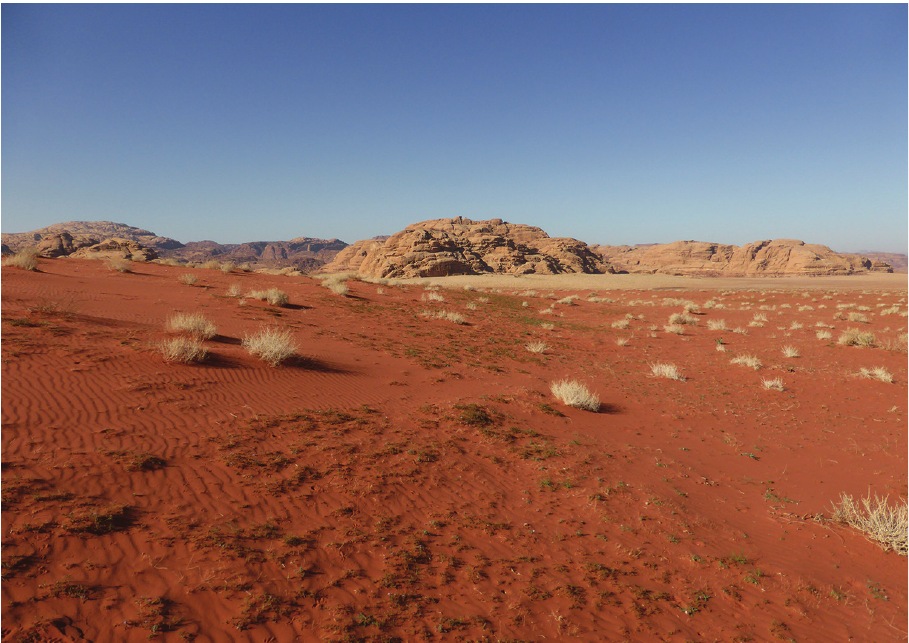
Figure 11. Habitat of Graphipterus minutus minutus : Shallow sand dunes in Wadi Ram, Jordan.